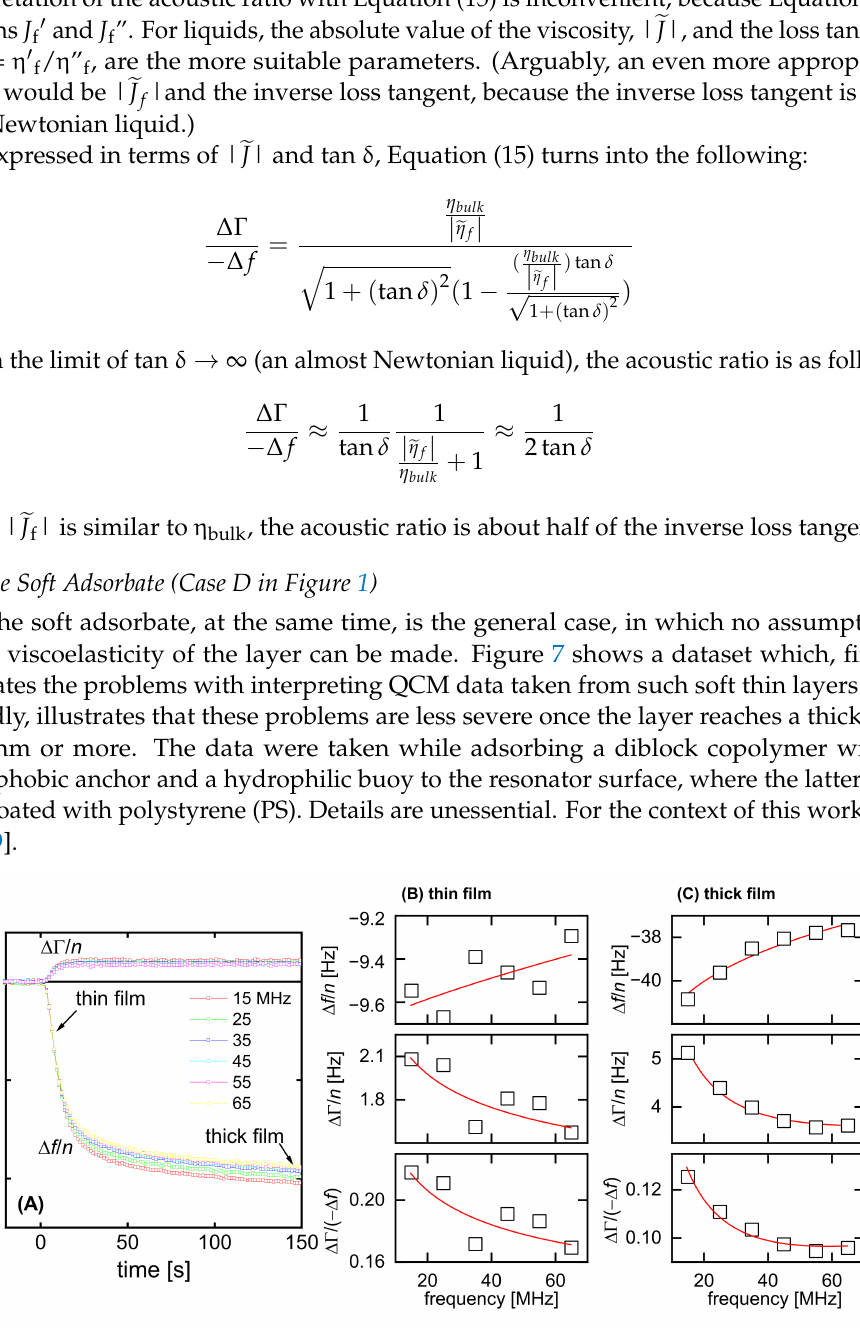
Figure 7. Adsorption of a polymer brush as an example, where the material parameters cannot be determined without making assumptions (early in the adsorption process, “thin film”), but where such an analysis becomes possible once the thickness exceeds 10 nm (“thick film”); the fractional noise decreases correspondingly ( A ). The raw data in ( A ) have been pre-averaged. Every data point is an average of four adjacent points of the raw data. The bottom panels in ( B , C ) show the acoustic ratios. The fits are not based on the acoustic ratios, but rather on ∆ f / n and ∆Γ / n themselves. The fit was produced with the PyQTM program by using Equation